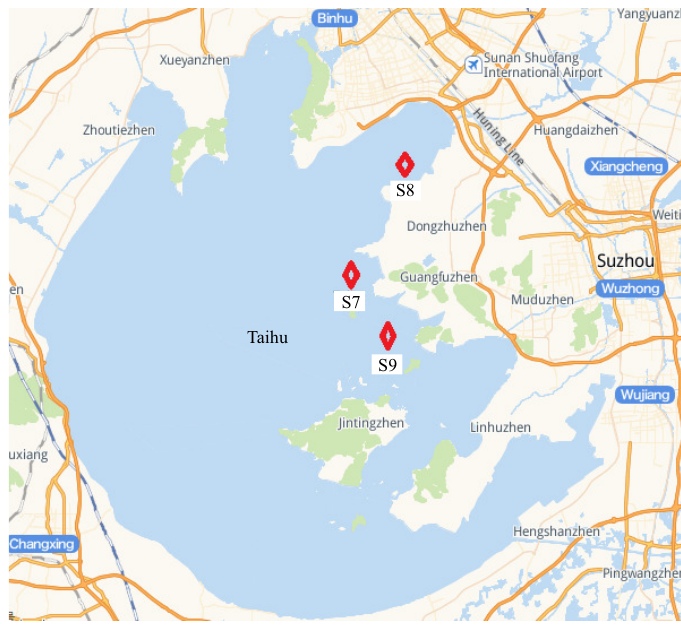
Figure 1. Locations of the monitoring platforms.